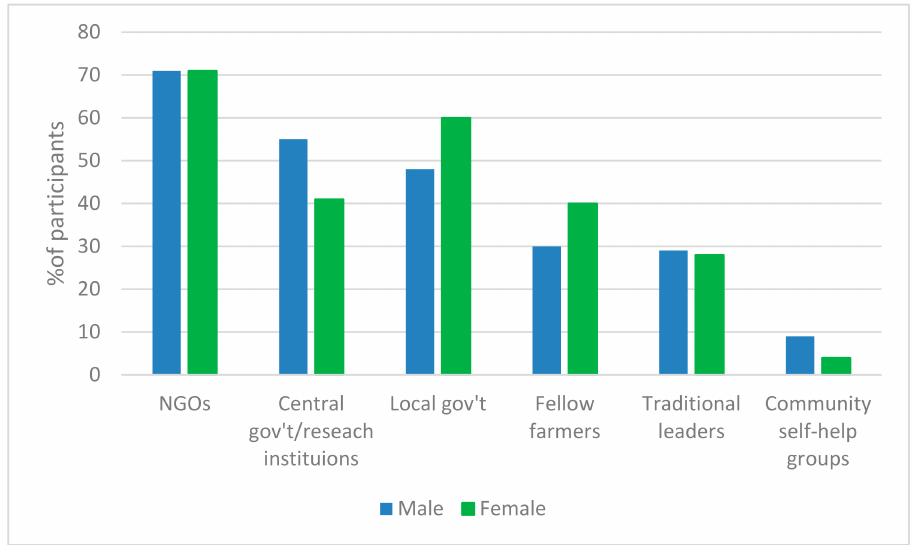
Figure 3. Farmers’ preferred sources of institutional support by